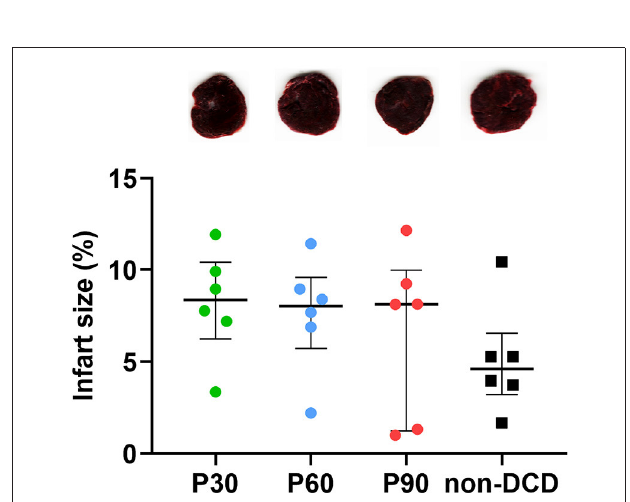
FIGURE 8 | Evaluation of infarct size for the donor heart during ESHP. Representative photomicrographs of TTC staining for the donor hearts during ESHP. Brick red: Live tissue; Pale tissue: Dead tissue. The lower panel showed the quantification of infarct size for the DCD hearts. n = 6 for P30, P60, and P90 groups, n = 5 for non-DCD group. Data represented as median and interquartile range. DCD, Donation after circulatory death; ESHP, Ex situ heart perfusion; TTC, 2,3,5-Triphenyl-tetrazolium